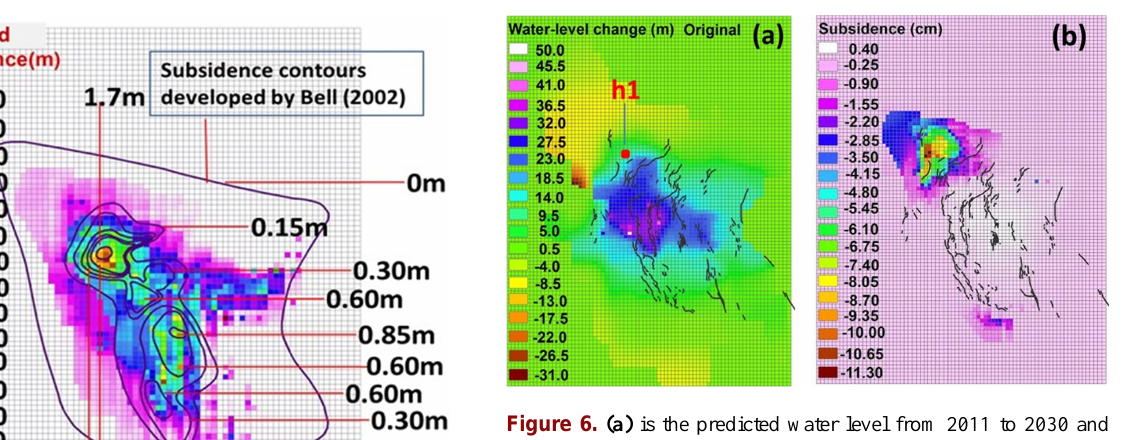
Figure 6. (a) is the predicted water level from 2011 to 2030 and (b) represents the predicted subsidence or uplift for the period